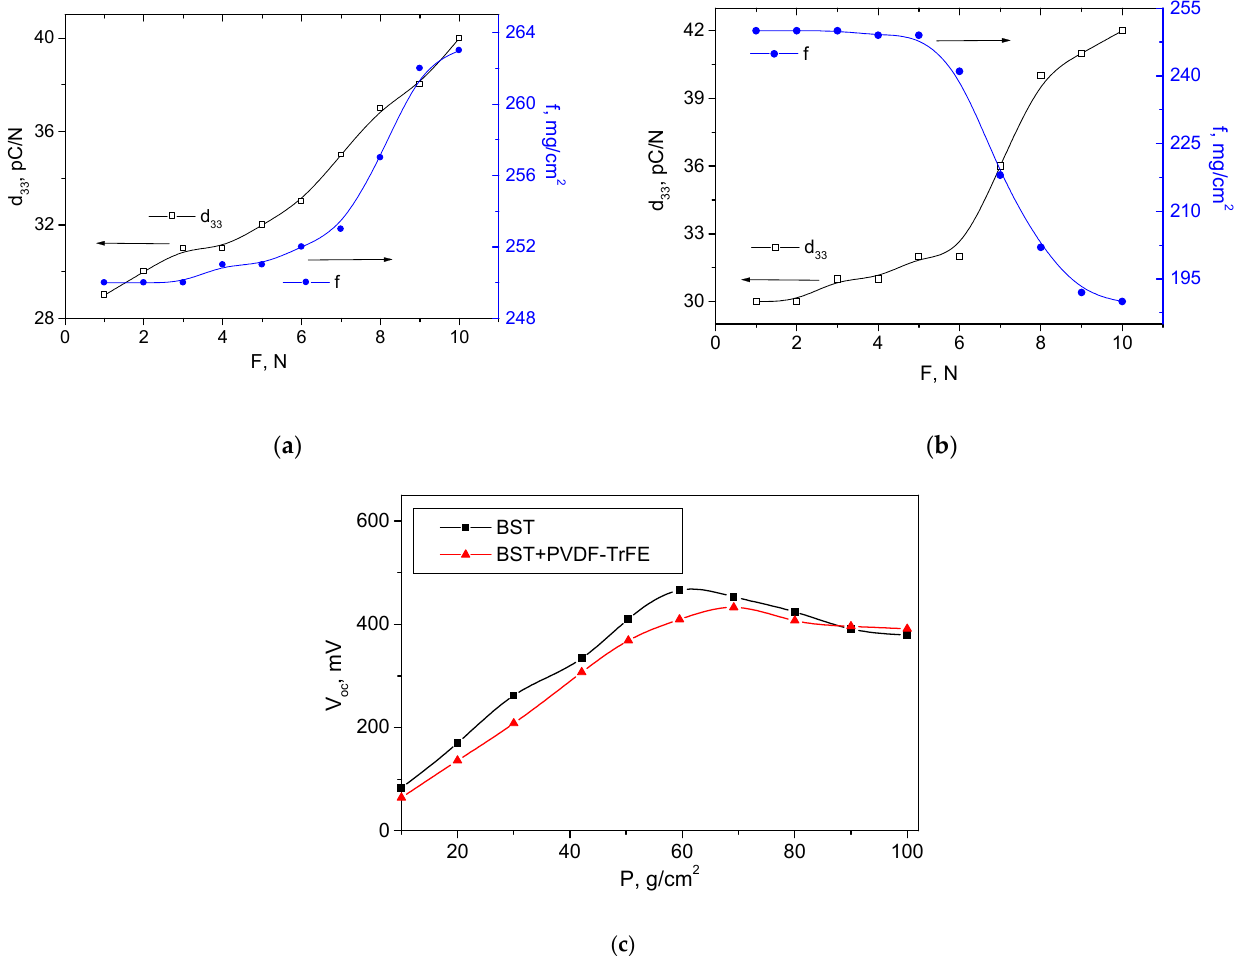
Figure 5. Piezoelectric coefficient and internal force for BST single material sample ( a ) hybrid BST+PVDF-TrFE multilayer device ( b ), and open circuit voltage versus pressure at a resonant fre- quency for the two devices ( c ).